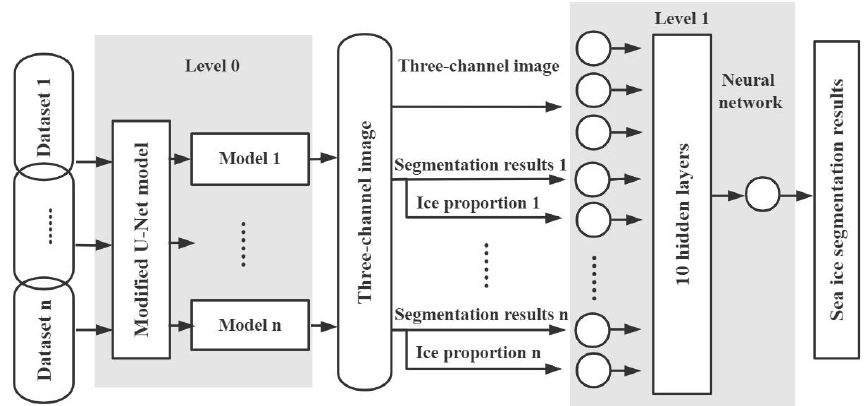
Figure 8. Overall architecture of the proposed integrated stacking model for generating the S1-derived sea ice cover